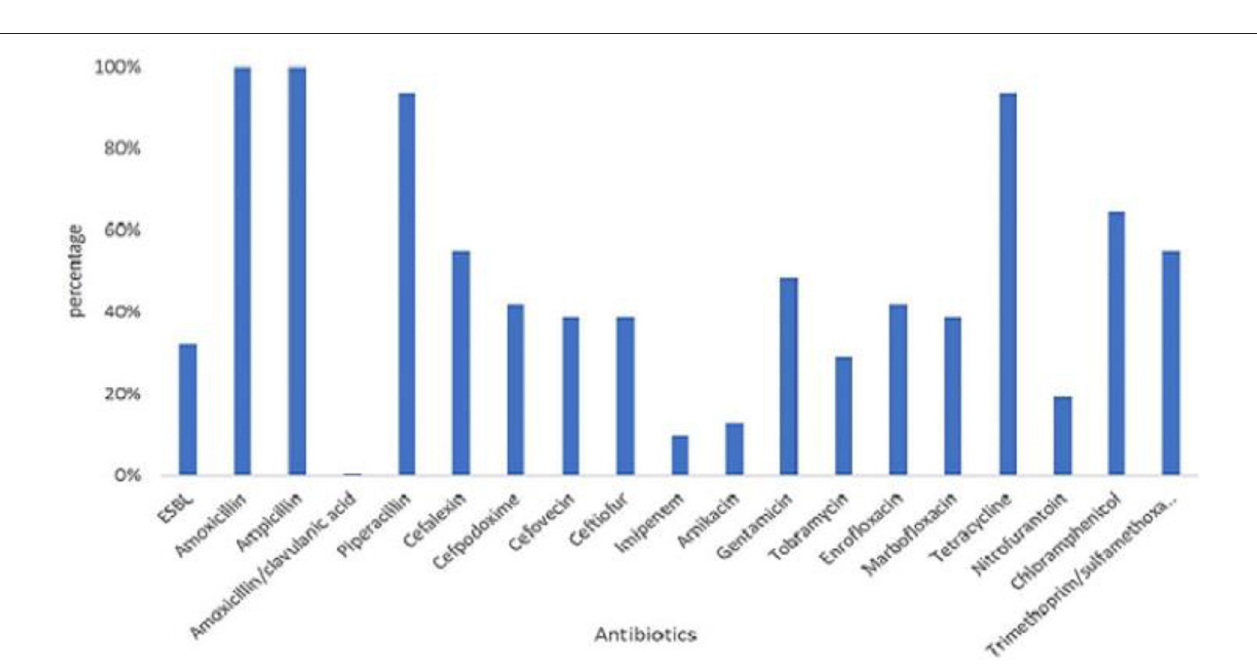
FIGURE 2 | Distribution of resistant rates against 18 antimicrobials and presence of extended- spectrum beta-lactamase (ESBL) characteristic among 105 colistin-resistant E. coli isolated from contracted pig farms in Thailand.